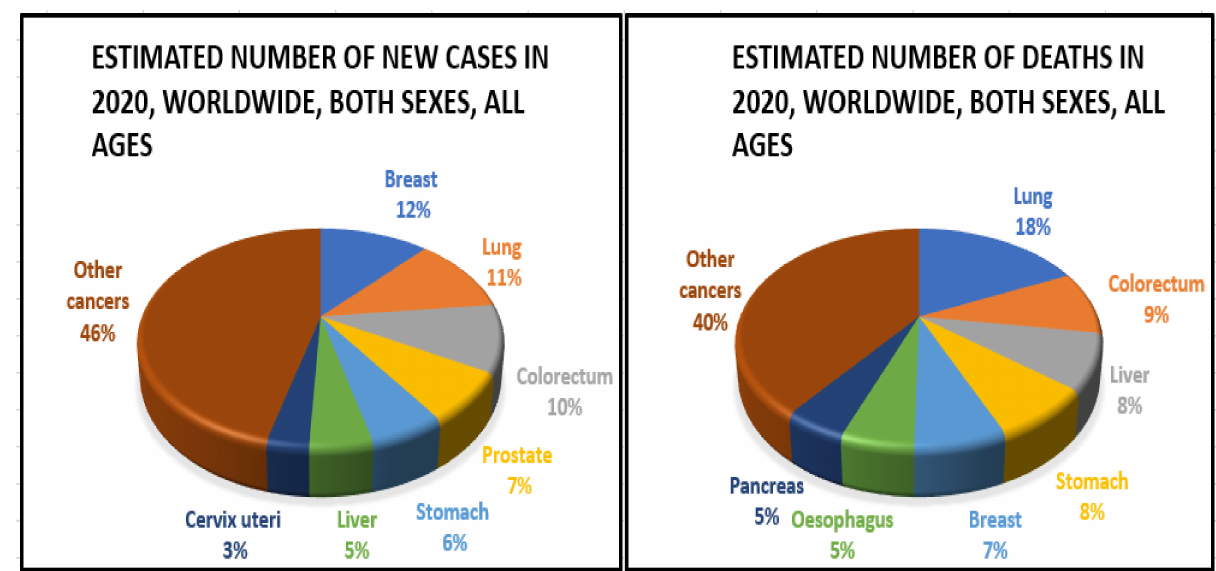
Figure 4. Epidemiology of colorectal